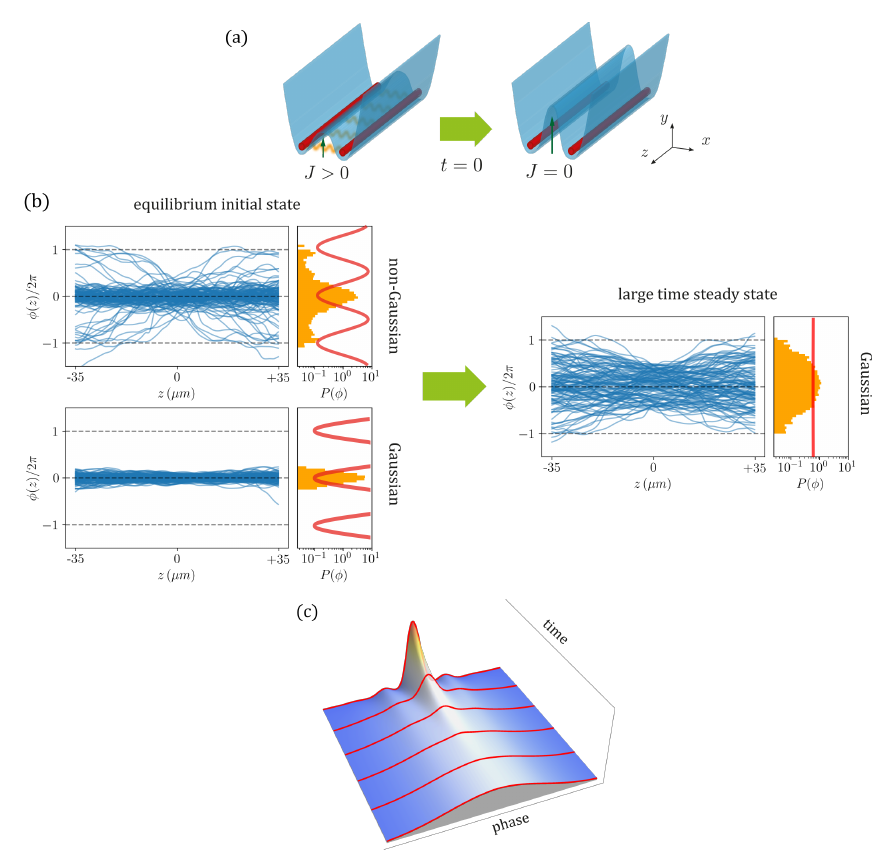
Figure 2: a) Illustration of the experimental setup: A gas of ultra-cold atoms confined into a one-dimensional trap can be split in two adjacent parallel traps controlled by an atom chip. By controlling the barrier height of the transverse double well potential which plays the role of a Josephson junction, one can engineer a many-body interaction of the cosine type. Ramping up the barrier height amounts to switching the interaction off. b) Preparing the gas at an equilibrium state and releasing it from the trap, the interference between the two atomic clouds reveals information about the spatial profile φ ( z , t ) of their relative phase at the time of the release. Repeating the experiment many times results in an ensemble of phase profiles from which one can extract the probability distribution of various physical observables derivable from the phase field. In the presence of interaction and at sufficiently high temperature, the distribution of the relative phase is highly non-Gaussian, exhibiting a central peak at φ = 0 and accompanied by side peaks at φ = ± 2 π with a lower height. This pattern clearly indicates the presence of solitons in the phase profiles and the concentration of the phase at the minima of the cosine potential. If the coupling J is very large, the interaction potential is approximately a steep parabola and phase fluctuations are Gaussian. Changing the interaction strength J from a nonzero value to zero and monitoring the subsequent time evolution of the phase profiles, we observe the transition from an initial non-Gaussian to an emergent Gaussian distribution. The plots show typical examples of equal-time ensembles of phase profiles and the corresponding histograms of phase values in all points z , as measured in the experiment. The three cases correspond to two different types of initial states (at intermediate or large J ) and a typical state that emerges after quenching to J = 0. (c) Illustration of the time evolution of the phase